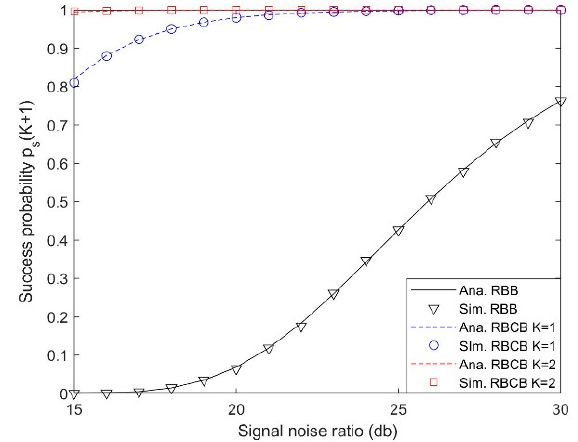
Figure 11. Comparison of success probability.